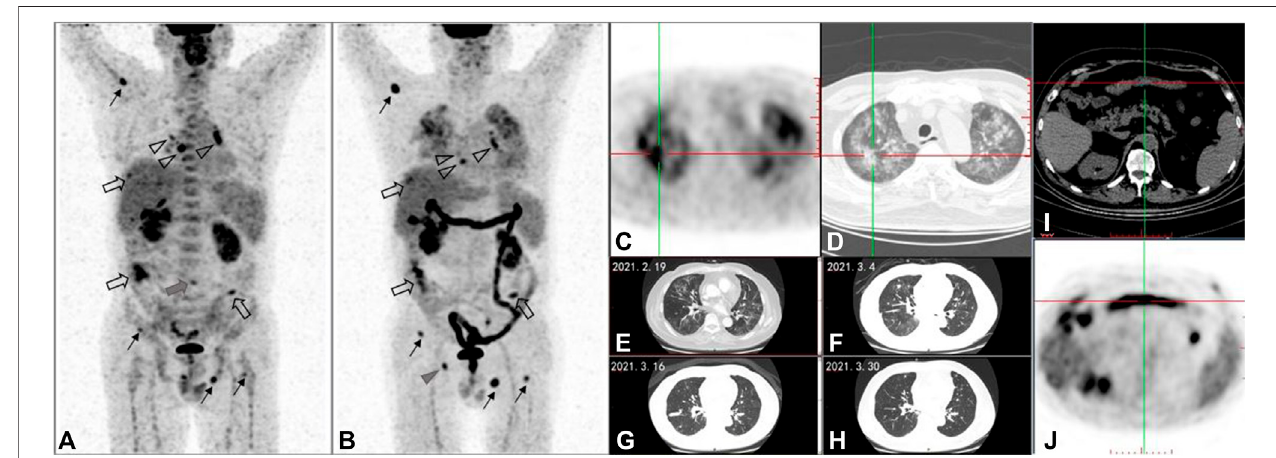
FIGURE1| A58-year-oldmalepatientwithmetastaticintrahepaticcholangiocarcinomawastreatedwiththethirdlineofipilimumab.Afterfourcyclesoftreatment, compared with 18 F-FDG PET/CT maximum intensity projection (MIP) image (A) before treatment, the posttreatment 18 F-FDG PET/CT (B-D) , (I,J) demonstrates the following: 1) multiple soft tissue density nodules in the peritoneum, which were larger in volume and higher in FDG uptake than before ( (A,B) hollow arrows); 2) multiple nodules without FDG uptake in both lungs, some of which are larger in volume than before and some of which have no change compared with before (cannot be showninMIPimages- (A,B) );3)thelymphnodeswithincreasedFDGuptakeinmediastinalareasandbilateralhilar,whichweresmallerinvolumeandFDG-uptakelower than before ( (A,B) hollow triangles); and 4) multiple foci of increased FDG uptake in bones: the FDG-uptake degree in vertebral body of lumbar 4 was signi fi cantly lower than before( (A) graytriangle);therightacetabularlesionwasthenewlesion ( (B) graytriangle);theremaining ostiallesions werehigherthan thosebefore( (A,B) blackline arrows). According to PERCIMT criteron: SMD was con fi rmed for the number of the newly FDG-positive lesions is less than 4. Meanwhile, in the light of imPERCIST5, PMD was also evaluated for the sum of SUL peak of the patient ’ s top fi ve target lesions after treatment was more than 30% higher than that of the top fi ve target lesions before treatment. As a result of clinical follow-up, the patient was con fi rmed PD and those lesion above were validated as metastases. PD was determined for the appearance of new lesion based on PECRIT. PMD was determined for new FDG-avid lesion at SCAN-2, which can be considered as UPMD in the line with iPERCIST. But the patient didn ’ t receive the next 18 F-FDG PET/CT between days 21 and 28 after treatment or 4 – 8 weeks later, so it could not be evaluated according to PECRIT and iPERCIST. Follow-up results showed the PFS for ICI was 6 months. Additionally, this posttreatment PET/CT displayed: 1) newly patchy ground glass density foci in